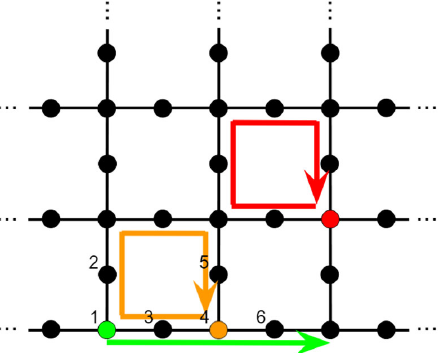
FIG. 2. Particle trajectories on the Lieb lattice under the measurement protocol in the infinite measurement (Zeno) limit with the perfect switching cycle ð T= 8 ¼ π = 2 Þ . In this regime, evolution becomes deterministic and particle trajectories can be seen explicitly. Particles localized in the bulk (red) at the start of the protocol and particles initialized at sites of type 3 or 4 (orange) on the edge trace out a closed loop after no more than five measurement cycles. On the other hand, particles initialized at sites of type 1 (green) or 6 on the boundary at the beginning of the protocol propagate along the edge, shifting by 1 dynamical unit cell every two measurement cycles (see Appendix H for